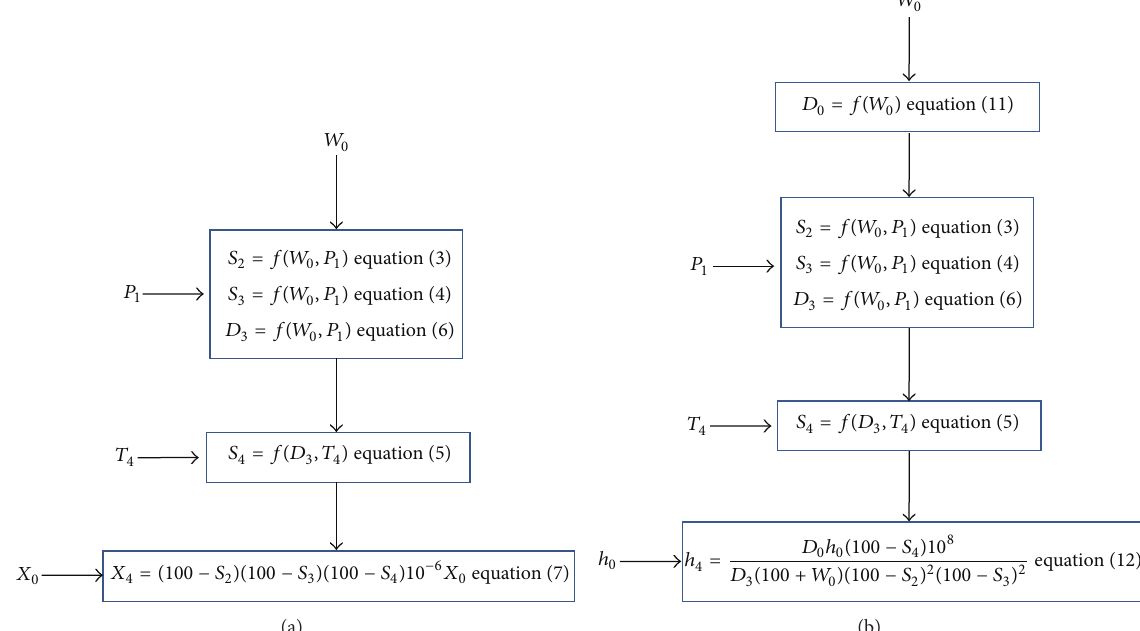
Figure 3: Flow charts for calculating the dimensional changes of ceramic tiles: (a) final length or diameter ( 𝑋 4 ) and (b) final thickness ( ℎ 4 ).